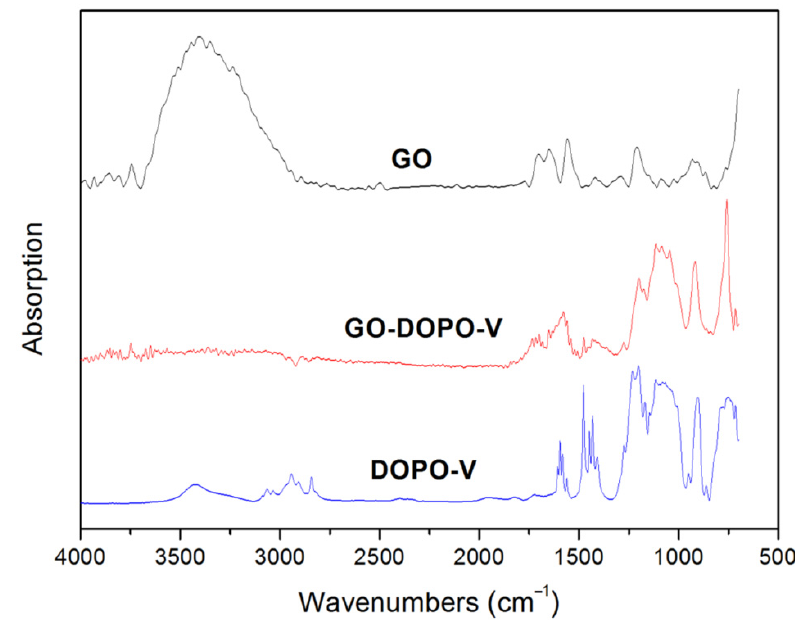
Figure 1. FTIR spectra of GO, DOPO-V and GO-DOPO-V.